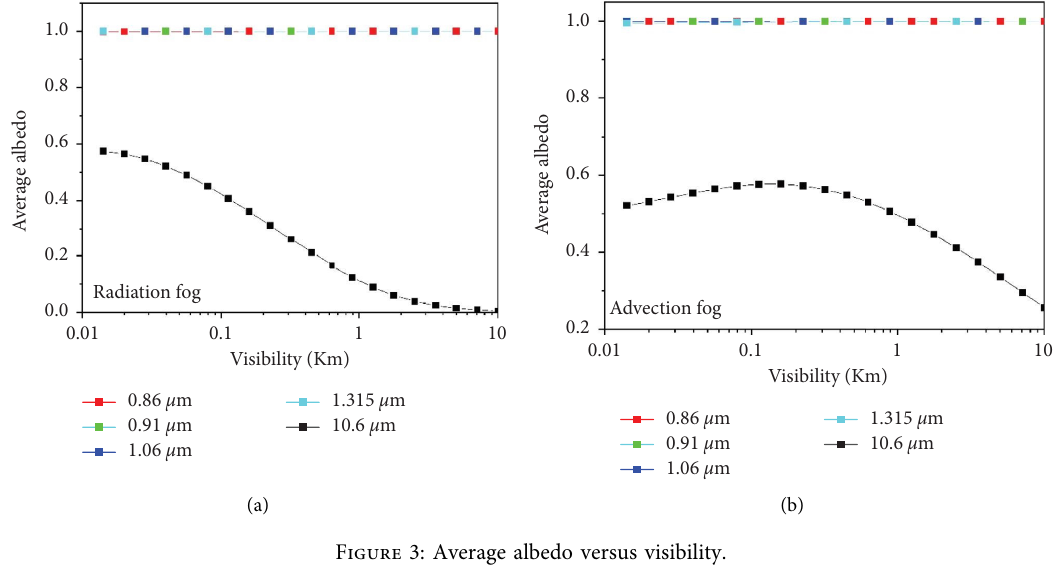
Figure 3: Average albedo versus visibility.